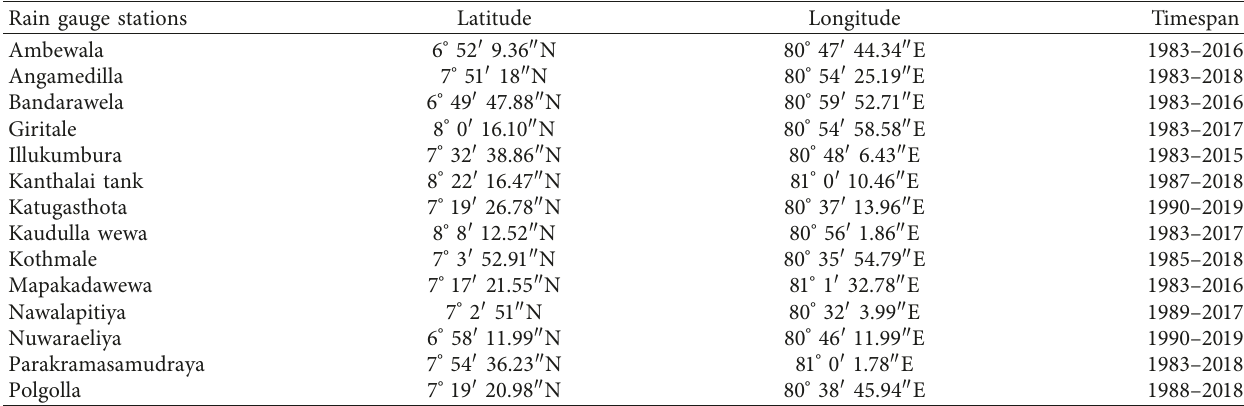
Table 1: Details of rain gauge stations.